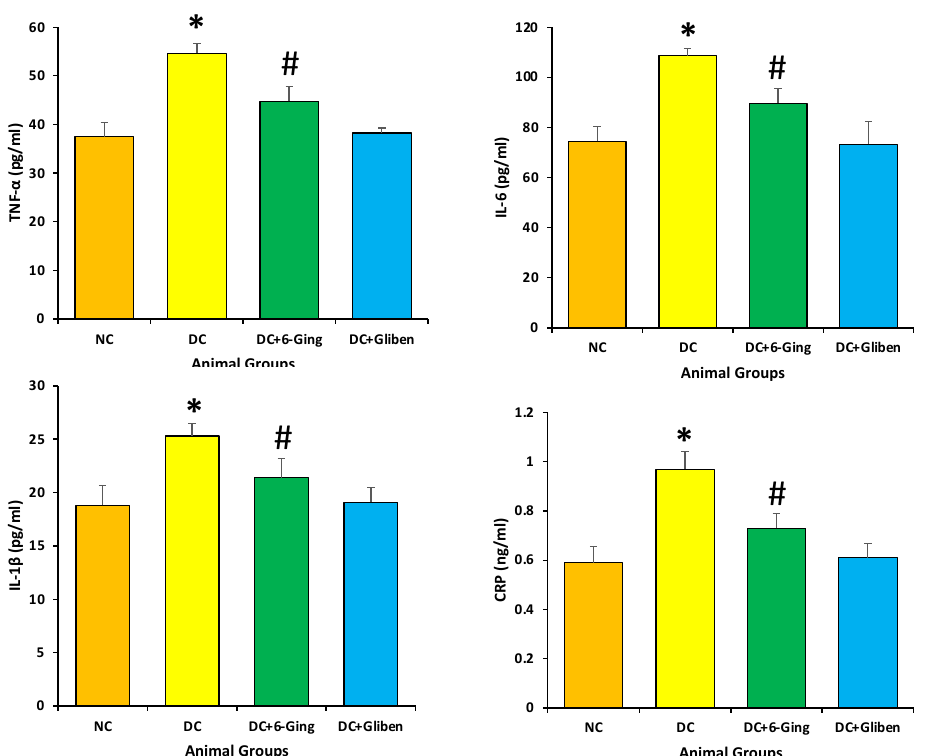
Figure 5. The inflammatory markers level in different groups of rats after 8 weeks of treatment. The rats were equally divided into 4 groups, each group (sample size = 8). Data are summarized as mean ± standard error of the mean (SEM). Groups: Normal control (NC); disease control (DC), i.e., STZ-treated group; treatment group (DC + 6-gingerol); positive control (PC) animal treated with STZ + glibenclamide; * p < 0.05 (significant difference of final b.w. between DC vs. NC) # p < 0.05 (significant difference of final b.w. between DC vs. DC + 6-gingerol).